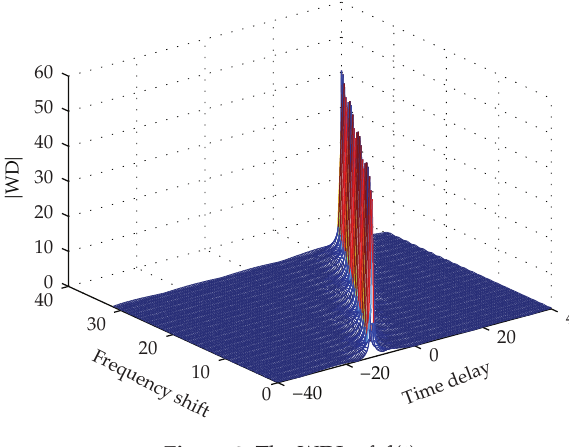
Figure 2: The WDL of f (cid:4) t (cid:5)